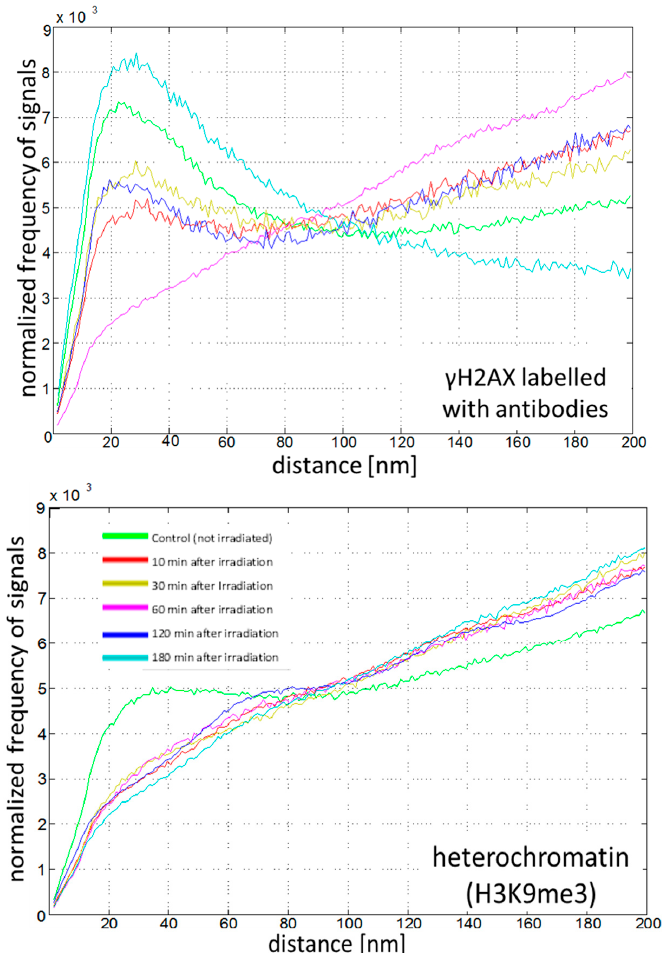
Figure 6. Normalized frequencies of the signal distances of fluorescence-labelled antibodies to γ H2AX phosphorylation sites (upper graphs) and heterochromatin H3K9me3 methylation sites (lower graphs), as determined by localization microscopy for different repair times after exposure to 3.9 Gy ionizing radiation. The differently colored curves were obtained from 20–25 cells from aliquots that were fixed at certain time points after irradiation (see insert in the lower figure). For comparison and interpretation of the curve shapes see Figure 1; for instance, for the pink curves see Figure 1A; for the green curve in the lower figure see Figure 1C; for the light blue curve in the upper image see Figure 1B. 2.5. Chromatin Response to Radiation Treatment Detected by COMBO-FISH of the ALU Consensus Regions